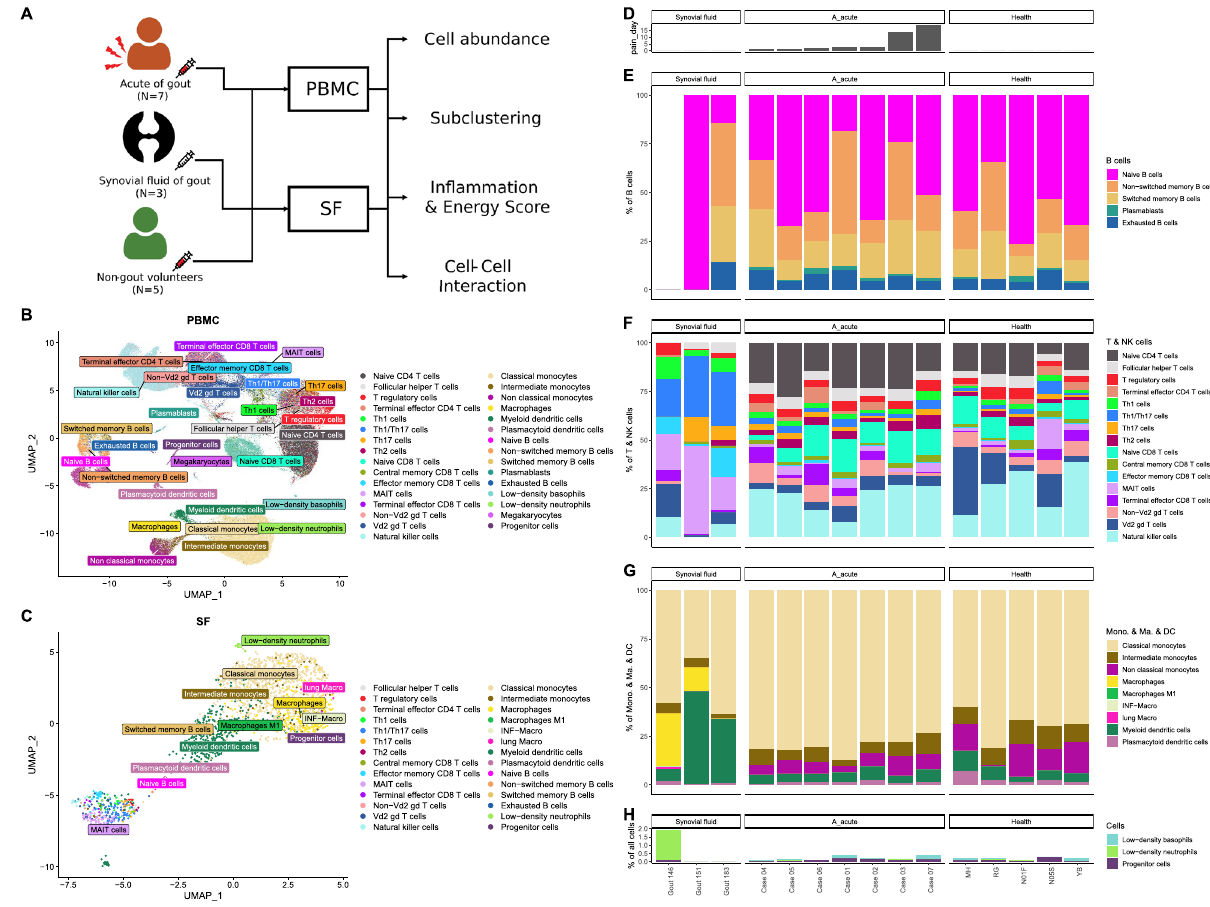
Figure 1. Immunological landscape of immune cells from healthy subjects and patients with gout. ( A ) Study design. Immune cells extracted from ( B ) peripheral blood mononuclear cells (PBMCs) and ( C ) synovial fluid (SF) are presented in uniform manifold approximation and projection (UMAP) coordinates. ( D ) Bar chart of pain duration in patients with gout. Relative abundance of various cell subpopulations: ( E ) B cells; ( F ) T and NK cells; ( G ) a monocyte series including monocytes (Mono.), macrophages (Ma.), and dendritic cells (DCs); and ( H ) megakaryocytes, progenitor cells, low-density neutrophils, and low-density in healthy subjects. Th1/Th17, effector memory CD8, MAIT, and macrophage cells were the major cells in SF (Fig. 2). Cell subclusters in PBMCs and SF in patients with acute gout and healthy controls. We further subclustered the subpopulation of immune cell types detected in PBMCs and SF. The results indicated increased levels of subcluster 5 intermediate monocytes (Fig. 3), subcluster 1 MAIT cells (Fig. S1), and subcluster 1 regu- latory T cells (Fig. S2) in the blood of patients with gout compared to healthy subjects. Gene panel analysis results obtained through UMAP analysis showing the distribution of intermediate monocyte cell subclusters in PBMCs and SF of acute gout and control groups are presented in Fig. 3A. Subclusters 0, 1, and 2 were dominant in patients with acute gout and healthy controls, subcluster 4 was dominant in SF, and subcluster 5 was more prevalent in acute gout patients than in healthy subjects (Fig. 3B,C). The gene panel used for subclustering is shown in Fig. 3D. More MAIT cells were represented by subclusters 0 and 2 in patients with acute gout than SF, whereas SF contained more subcluster 3 MAIT cells, and acute patients with gout had dramatically more subcluster 1 cells than healthy subjects (Fig. S1). Among regulatory T cells, subclusters 1, 2, 3, and 4 were dominant in the blood of acute gout patients, whereas subcluster 0 was dominant in SF, and only subcluster 1 had significantly differ- ent blood levels between acute gout patients and healthy subjects (Fig. S2). Among Th1/Th17 cells, subcluster 0 was dominant in SF, and no significant differences among subclusters were detected in the blood of patients with acute gout and healthy subjects (Fig. S3). Only a few NK cells were detected in SF, and most NK cells were classified as subcluster 10, with no significant difference in blood samples between patients with acute gout and healthy subjects (Fig. S4). Three macrophage subclusters were detected in SF, and two subjects showed dominant subcluster 2 levels, with higher MHCII expression (Fig. S5). Too few macrophages were detected in the PBMCs of gout patients and healthy controls to evaluate significant differences.